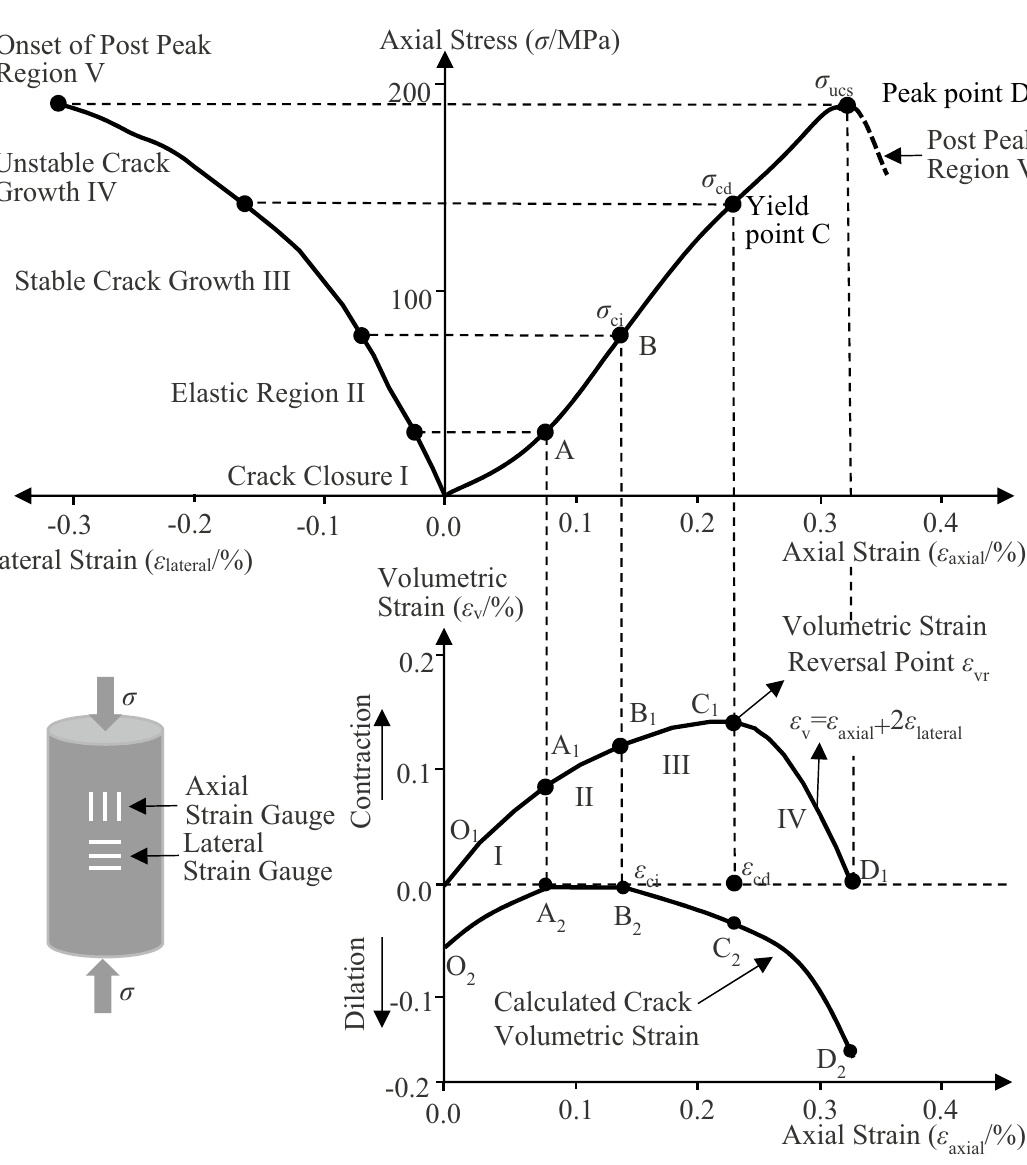
Figure 2. Stress–strain diagram showing the steps of crack development and relationship with volumetric strain-axial strain curve (modified after Martin and Chandler 43